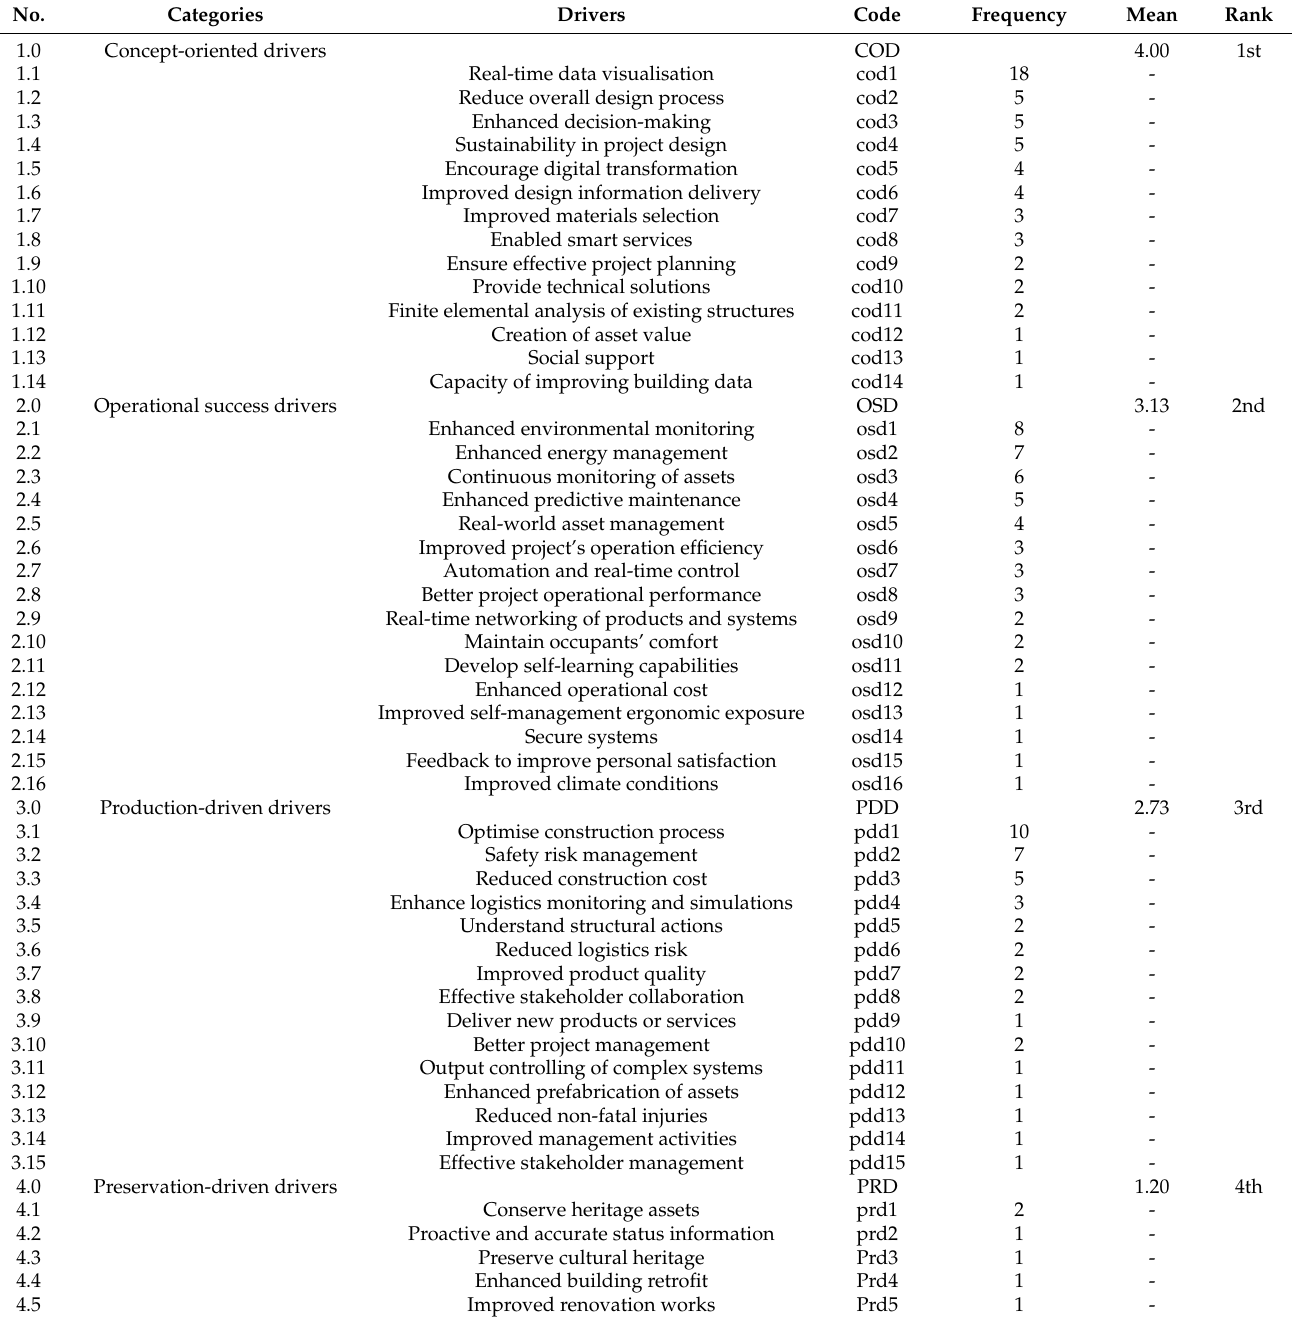
Table 4. Typology of Drivers for DT adoption in CI